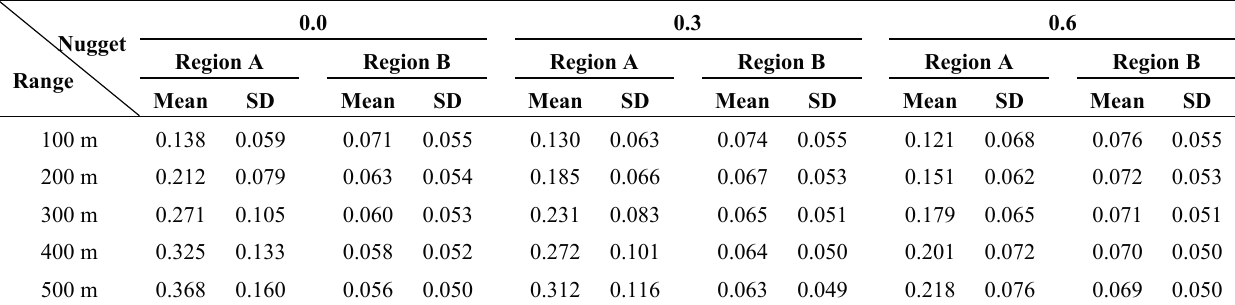
Table 1. Biases of the means and standard deviations between the samples and the